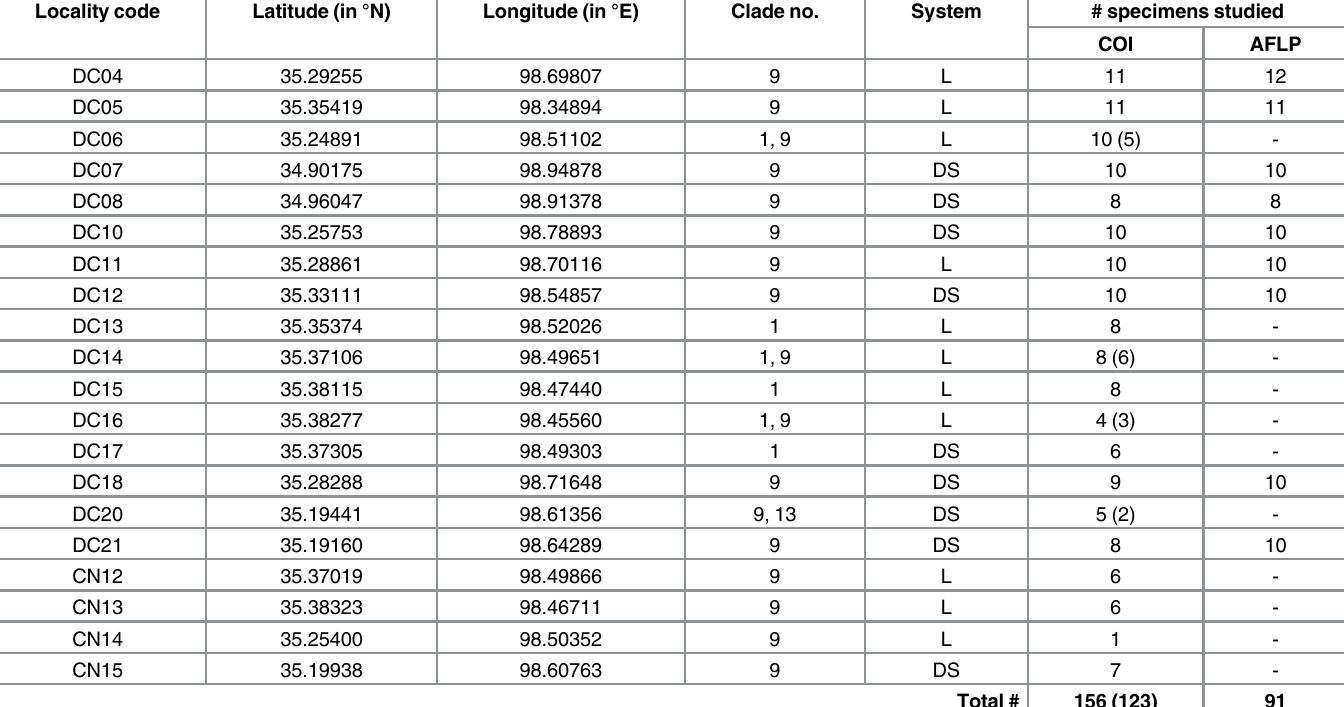
Table 1. Locality information for Radix populations collected in the Lake Donggi Cona drainage system. It includes locality code (DC = this study; CN = Oheimb et al. [6]), geographical coordinates, clades occurring at the respective locality inferred from the Bayesian-inference analysis (see Fig 1), type of system (L = lake and DS = drainage system), and the number of specimens studied (for populations that contain specimens belonging to different clades, the number of specimens for the most abundant endemic Radix clade 9 are shown in brackets). Locality